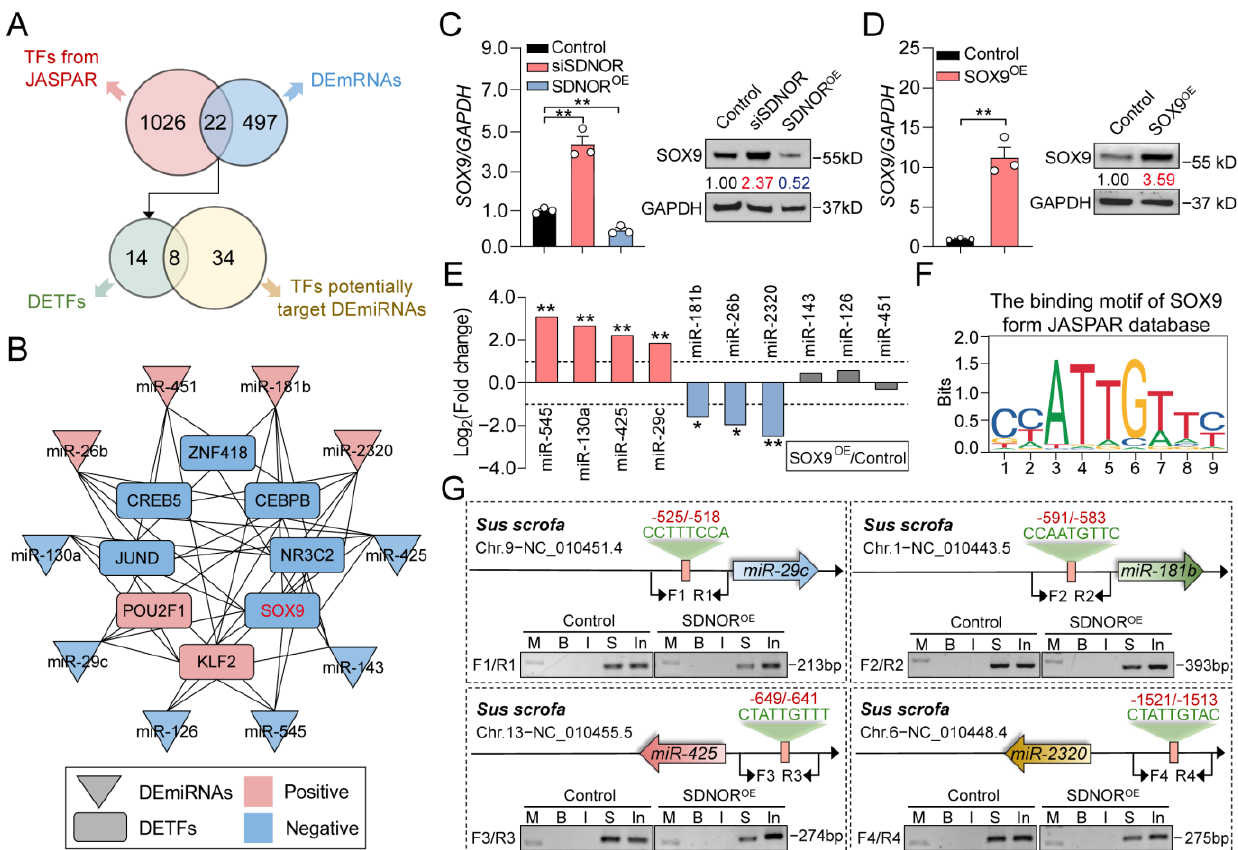
Figure 5. SOX9, suppressed by SDNOR, regulates the transcription of DEmiRNAs by acting as a TF. ( A ) Identification of the DETFs which potentially target the DEmiRNAs. ( B ) Establishment of the SDNOR-mediated DETF – DEmiRNA regulatory network. ( C ) The mRNA and protein levels of SOX9 in GCs after knockdown or overexpression of SDNOR were detected by RT-qPCR and Western blot assays. ( D ) The expression efficiency of SOX9 in GCs was measured by RT-qPCR and Western blot assays. ( E ) The expression patterns of DEmiRNAs in SOX9-overexpressed GCs were detected by RT-qPCR with three independent replicates. y -axis indicates the log 2 -transformed fold change of DEmiRNAs. Columns in red, blue, and gray indicate upregulated, downregulated, and not significant. ( F ) Analysis of the SOX9 motif by JASPAR prediction tool. ( G ) ChIP assays. Diagram showing the SOX9 motifs within the promoter of DEmiRNAs. The corresponding primers used for ChIP assays are shown as arrows (F1/R1-F4/R4). M indicates 2000 bp DNA ladder marker, B indicates blank, I indicates IgG, S indicates SOX9, and In indicates 0.2 input. Data in E - F are shown as mean ± S.E.M. with three independent replicates. Data in C - D are shown as mean ± S.E.M. with three independent replicates. Significance in C - E was analyzed with a two-tailed Student’s t -test. For Western blot assays in C - D , significance between experimental and control groups is shown in different colors. Red and blue indicate significantly up- and downregulated, respectively. * p < 0.05, ** p < 0.01.